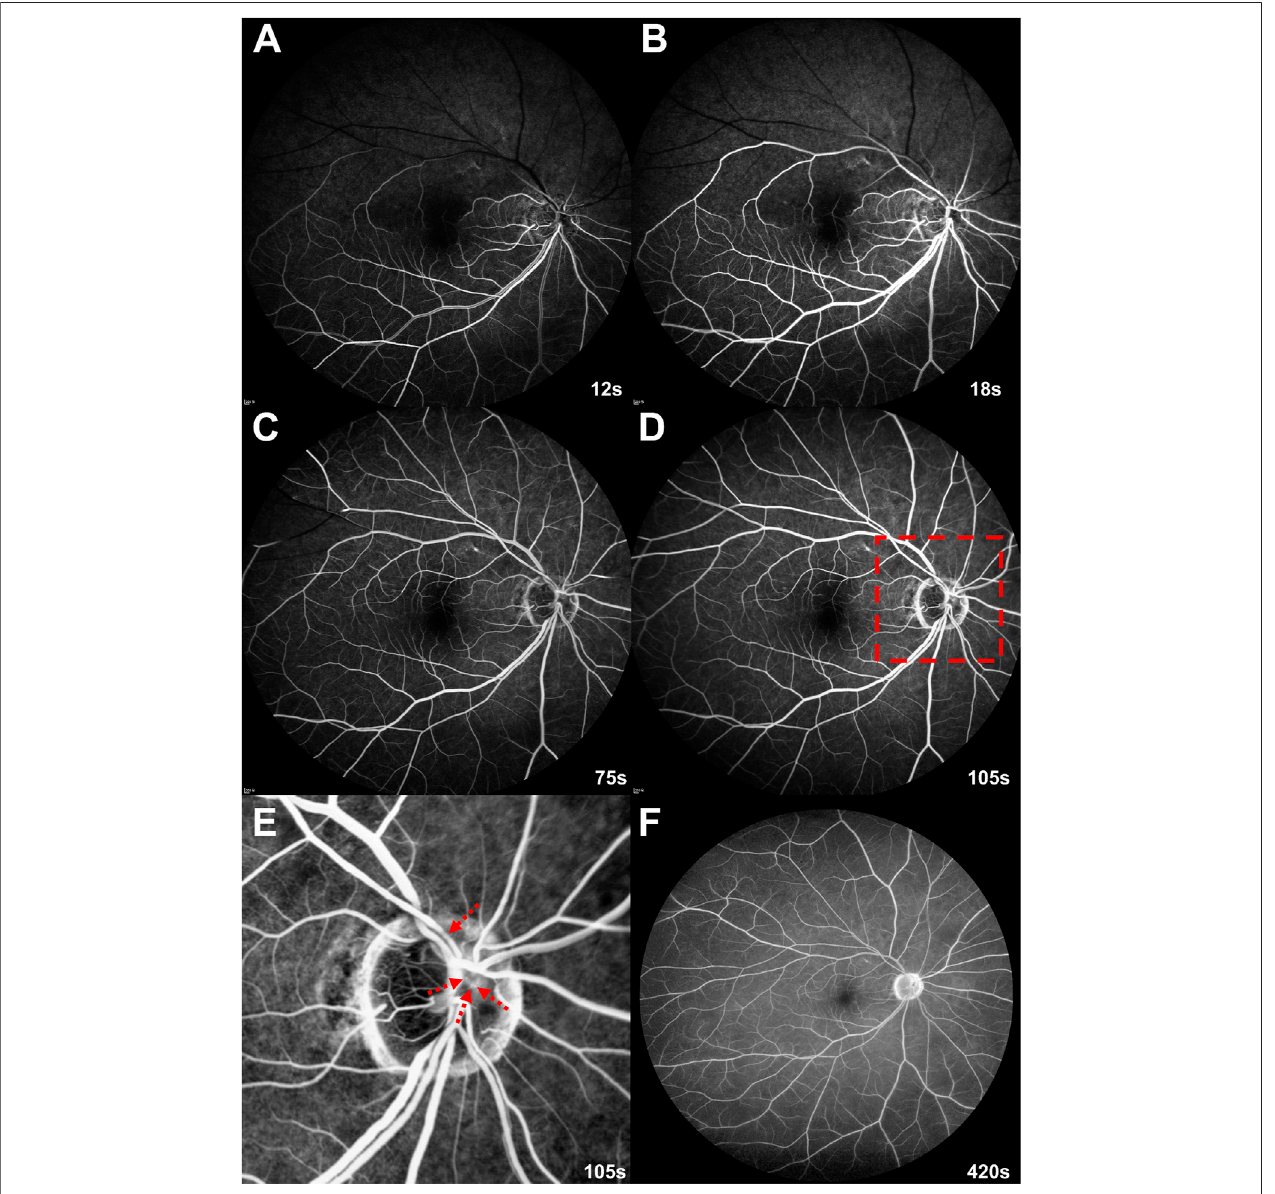
FIGURE 2 | Initial fl uorescein angiography on day 7 post-vaccination (A – D) Arterial fi lling delay to the upper branches protracts venous return. (E) An enlarged imageofthereddashedrectangleon (D) .Fluoresceinangiographyatthevenousphasediscriminates fl uorescein-stainedmicrothrombi(reddashedarrows)intheupper proximal branches of the right retinal arteries. (F) Until the late phase, dye leakage and retinal vasculitis are absent.